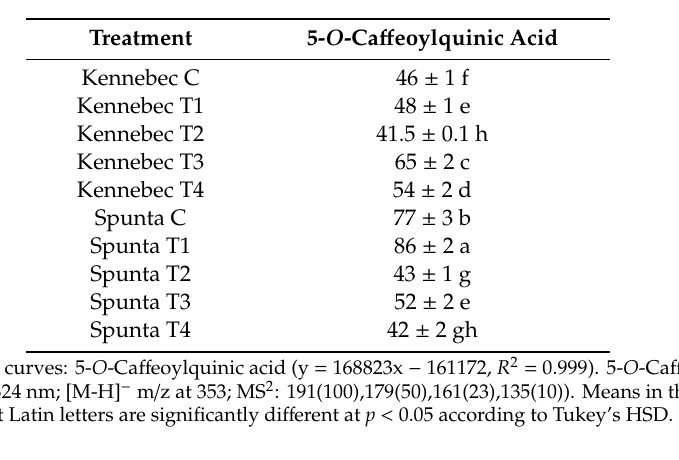
Table 9. Quantification of the phenolic compounds (mg/kg fw) present in the studied potato varieties in relation to the fertilization regime (mean ± SD).